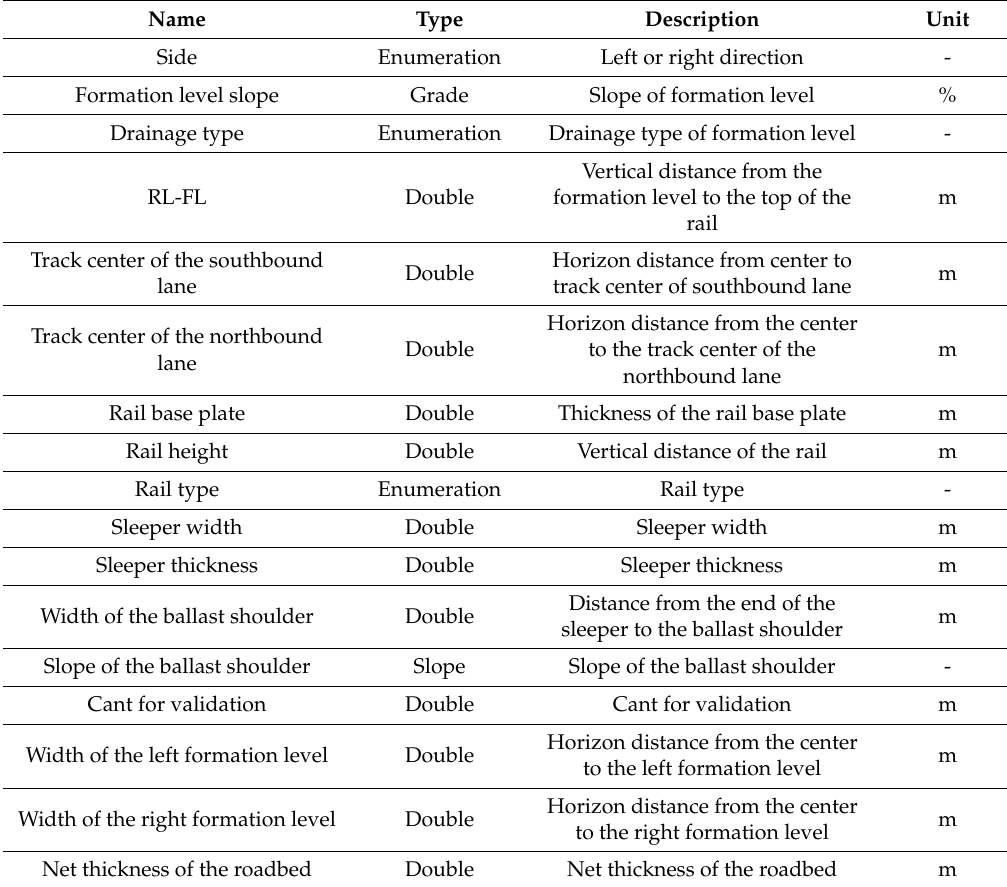
Table 5. Example of library parameter for (ballasted